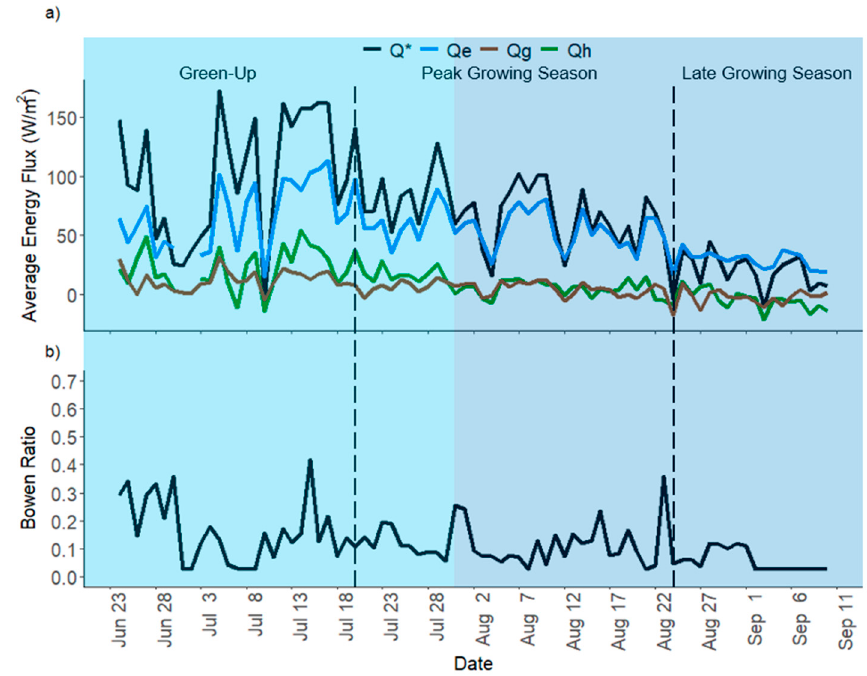
Figure 5. Gap filled timeseries data for daily average: ( a ) net radiation (Q*), sensible heat flux (Q h ), latent heat flux (Q e ) and ground heat flux (Q g ) in W/m 2 observed or derived from measurements at the site; and ( b ) Bowen ratio ( β ). The light blue vertical highlighted area represents the Stable Shade period of our study and darker blue vertical highlighted area the Dynamic Shade period. Table 1. Average daytime, defined as time when Q* > 10 W/m 2 , range of incoming solar radiation (K ↓ ) and components of the energy balance during the clear sky days within each phase of the study period (W/m 2 ). K Q* Q e Q h Q g